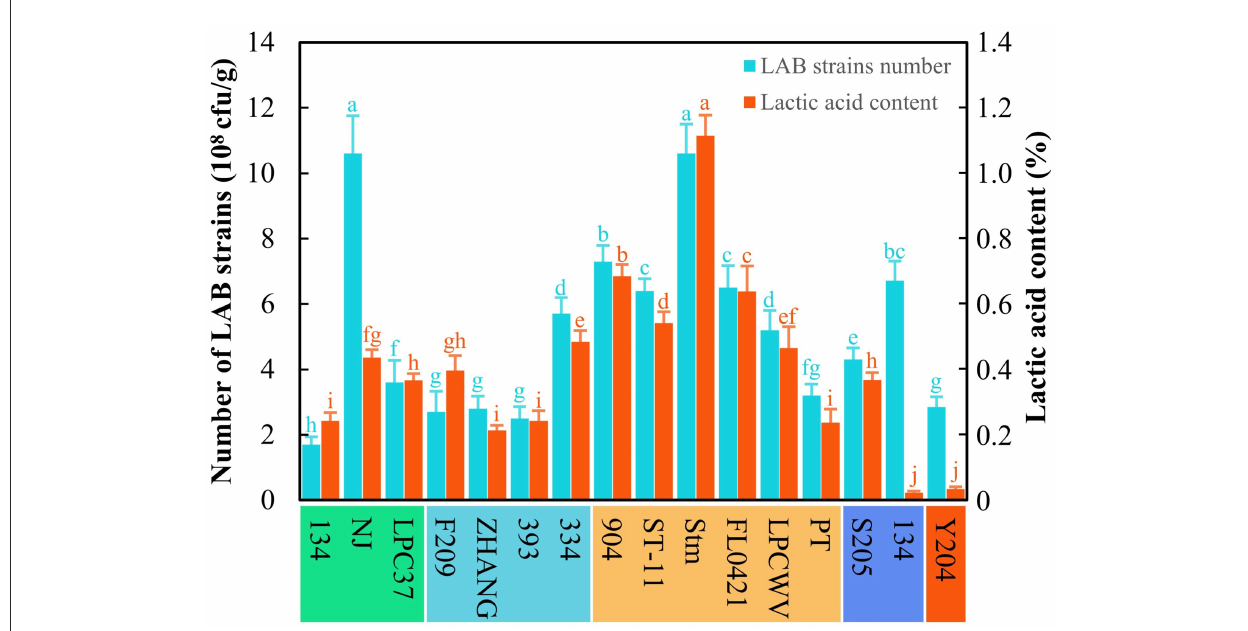
FIGURE1 Screening of LAB strains for producing fermented astragalus. Here, five species of LAB were used, namely L . paracasei (134, NJ, LPC37), L . casei (F209, ZHANG, 393, 334), L . pentosus (904, ST-11, Stm, FL0421, LPCWV, PT), P . acidilactici (205, 134), and L . plantarum (Y204) (one-way ANOVA was performed to evaluate the difference). The same letter showed no significant difference between the chosen groups, while the different letters revealed that significant difference existed between the chosen groups.